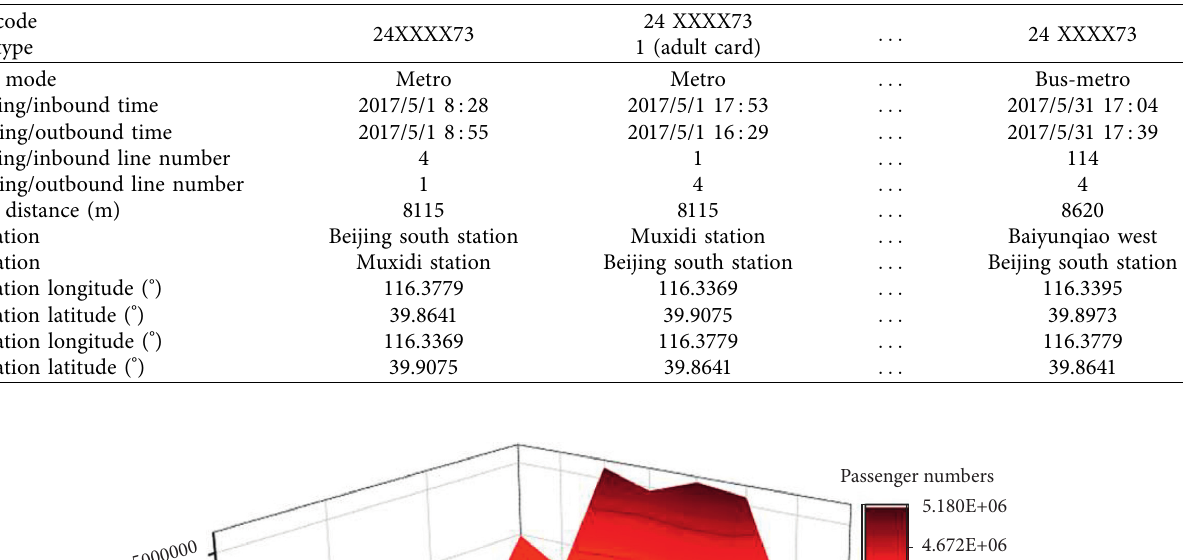
Table 2: Travel chain data sample of a PT